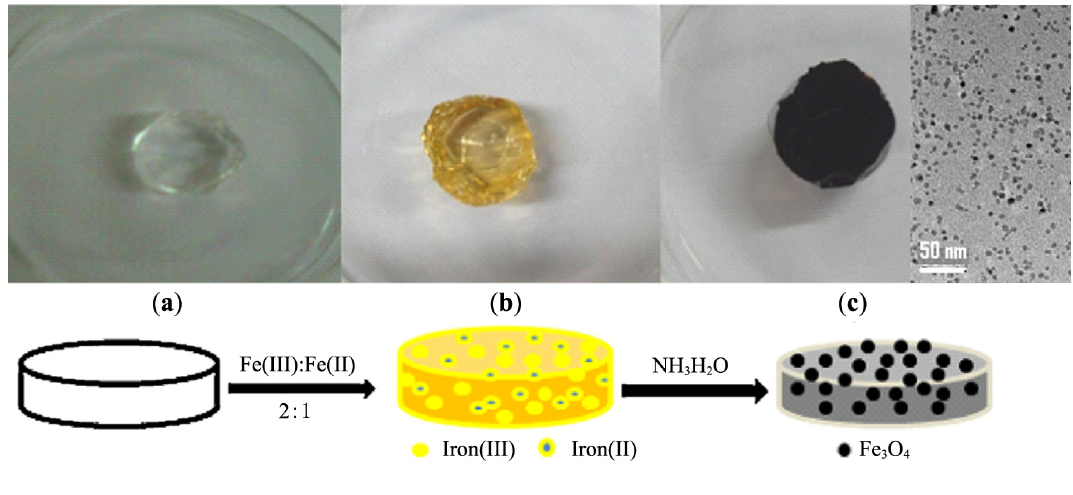
Figure 32. Schematic views and pictures of polyacrylamide (PAAm) hydrogel networks at three steps of loading by magnetite NPs: ( a ) swollen hydrogel; ( b ) iron ion-loaded hydrogel; and ( c ) magnetite NPs in the hydrogel matrix, inset: TEM image showing well-dispersed MNPs of uniform size. Reprinted with permission from [59]. Copyright 2009 Elsevier